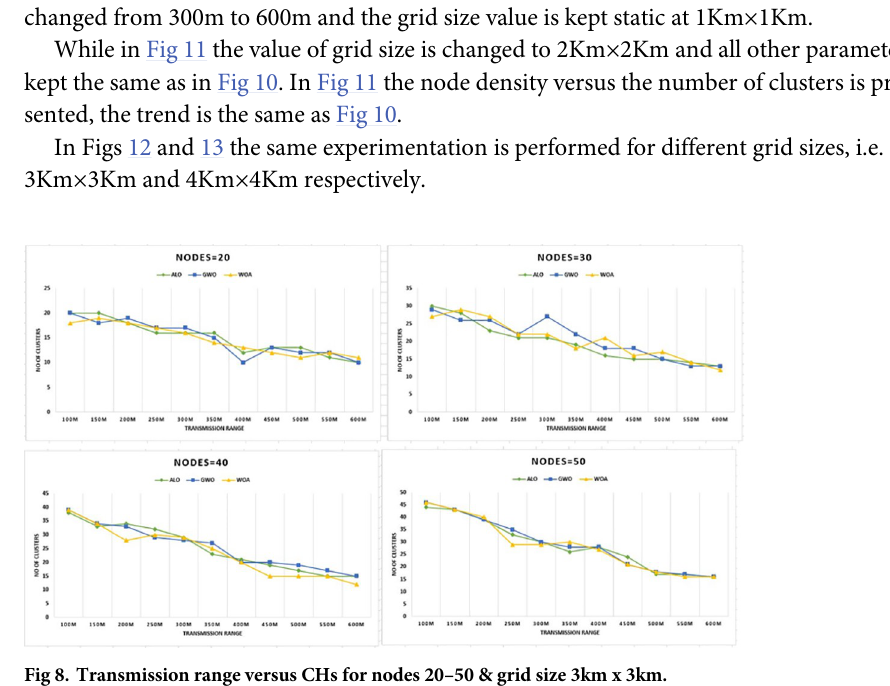
Fig 8. Transmission range versus CHs for nodes 20–50 & grid size 3km x